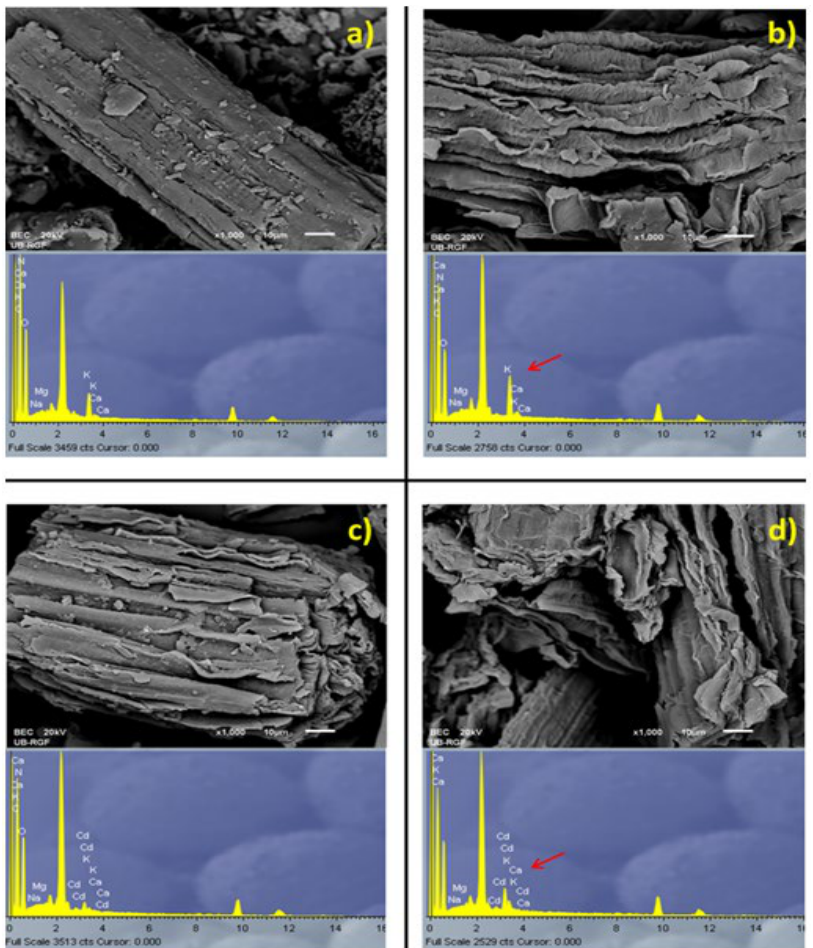
Figure 2. SEM micrograph and EDX spectrum of the CS ( a ) and MCS ( b ) before and the CS ( c ) and MCS ( d ) after Cd 2+ adsorption.